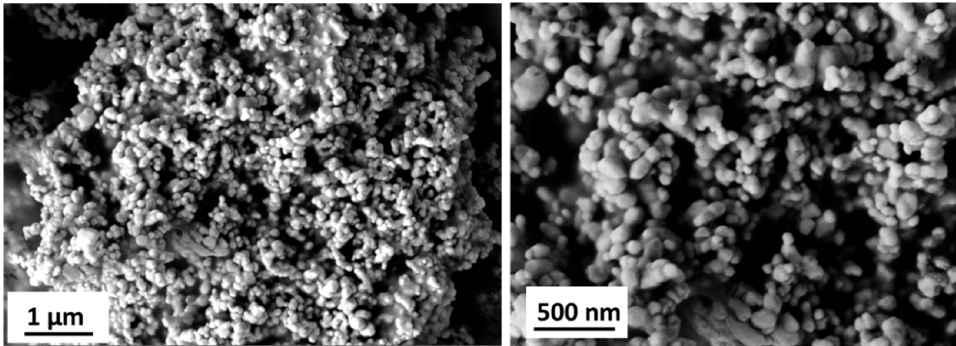
Figure 1. SEM micrographs of the CuO powder considered in this study.